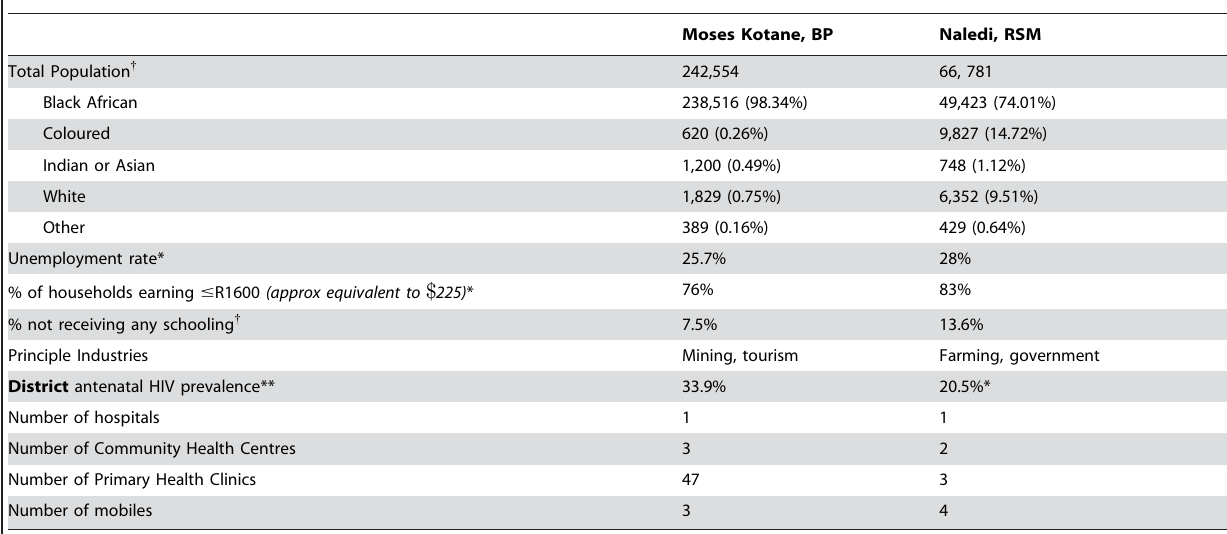
Table 1. Characteristics of Study